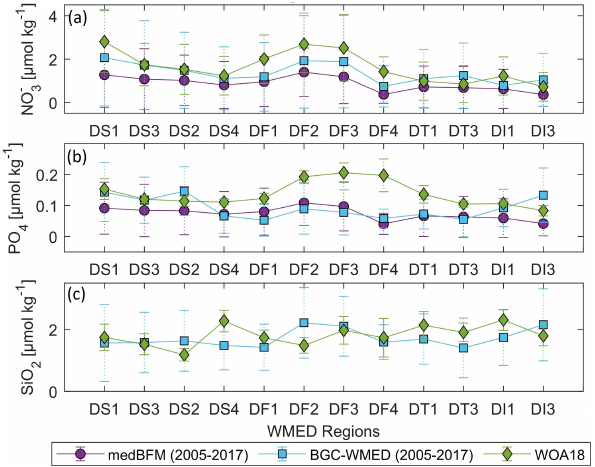
Figure 15. Nutrient average concentrations and standard deviation comparison in the upper 150m (values in Table